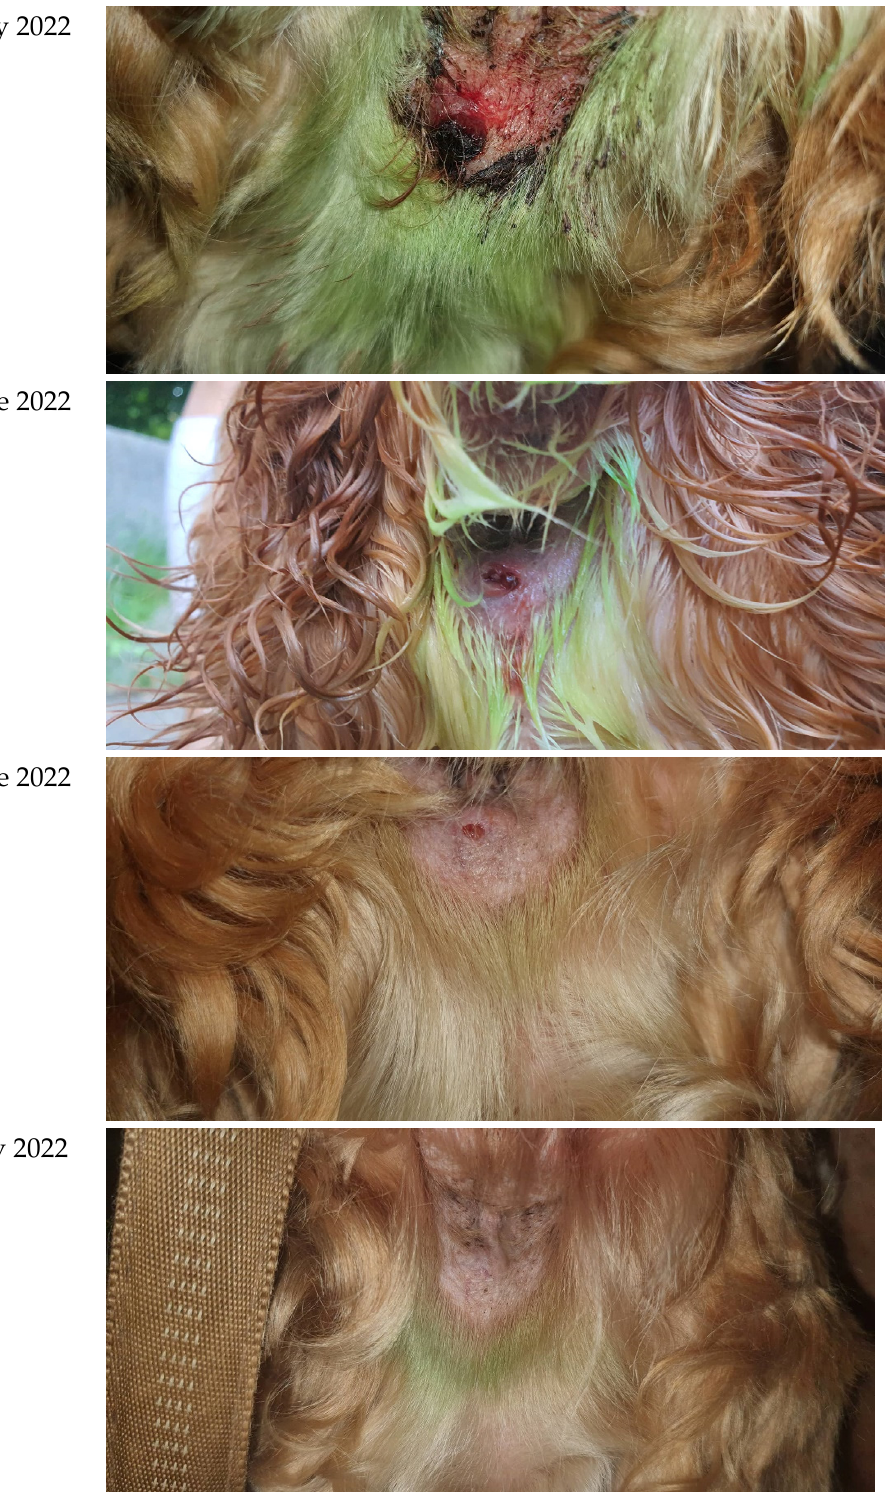
Figure 2. Treatment results of patient 2 with SILVER STOP ® cream.